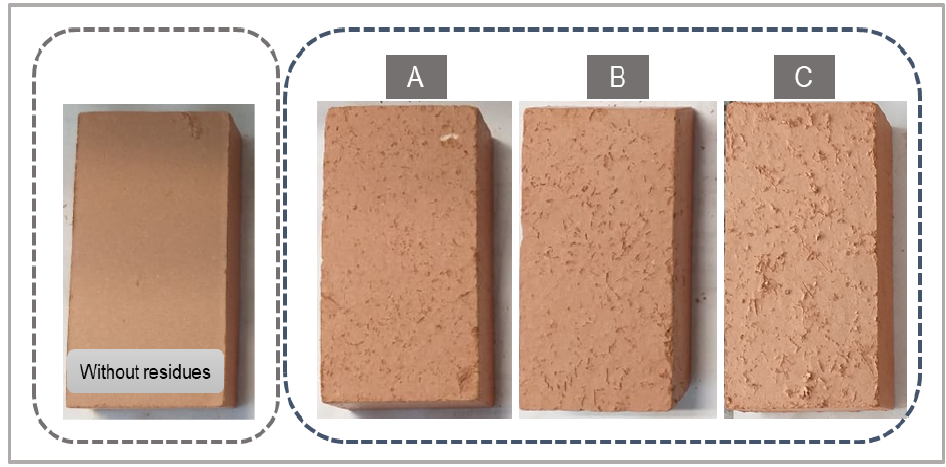
Figure 12. Macroscopic appearance of clay ceramics including spent biomass of: ( A ) pine sawdust, ( B ) sunflower seed hulls, ( C ) corn residues mix, and comparison with a sample without residue addition.